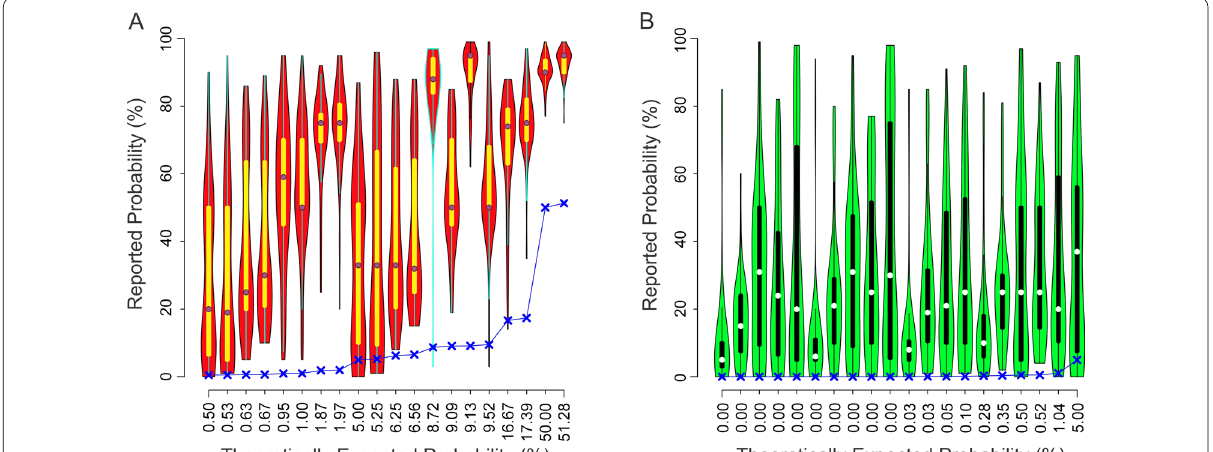
Fig. 3 Probability estimates reported by non-professional subjects during the E-type trials in Experiment 2. The data in this figure are plotted using the same conventions as in Fig. 1. The recall rates the same set of subjects during the paired D-type trials across the same conditions are shown in the same order in Fig. 5. See text for